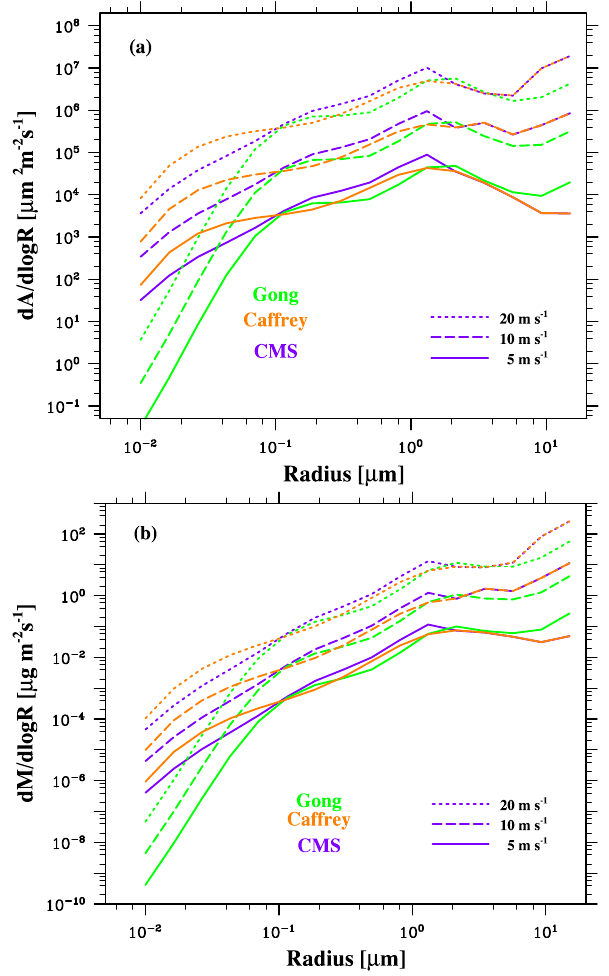
Fig. 2. Gong, Caffrey, and CMS source functions shown for (a) cross-sectional area and (b) mass as a function of dry radius. The three groups of curves represent the size distribution under wind speeds of 5, 10, and 20ms − 1 from bottom to top. The source func- tions are corrected for gravitational sedimentation following Hoppel et al.